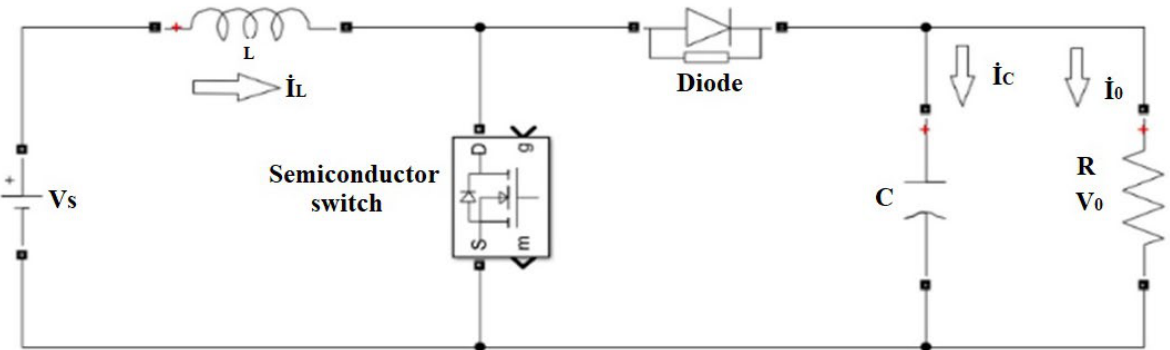
Figure 5. DC–DC boost converter Figure 5. DC– DC boost converter circuit.